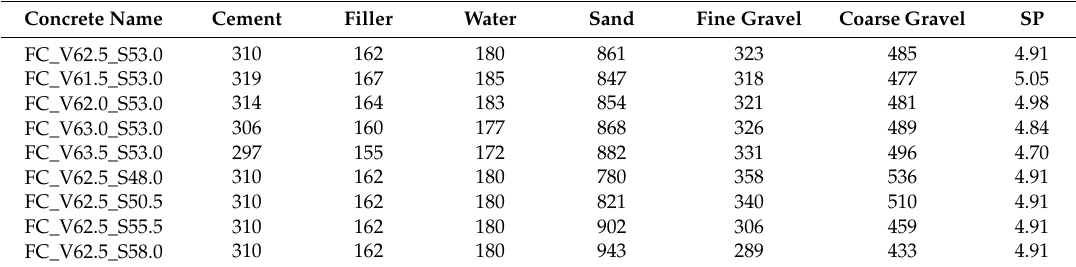
Table 1. Mix proportions of concrete mixtures (kg/m 3